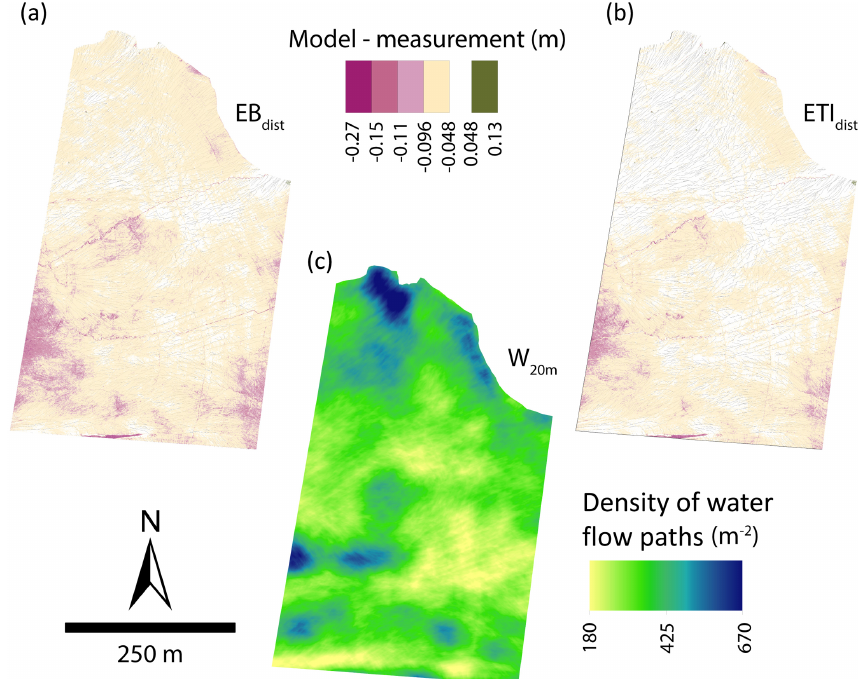
Figure 6. Model error with magnitude greater than 0.048m underlain by flow path features with potential upstream accumulation greater than 15m 2 for (a) EB dist and (b) ETI dist . Density of flow accumulation features within a 20m radius of each cell (c)